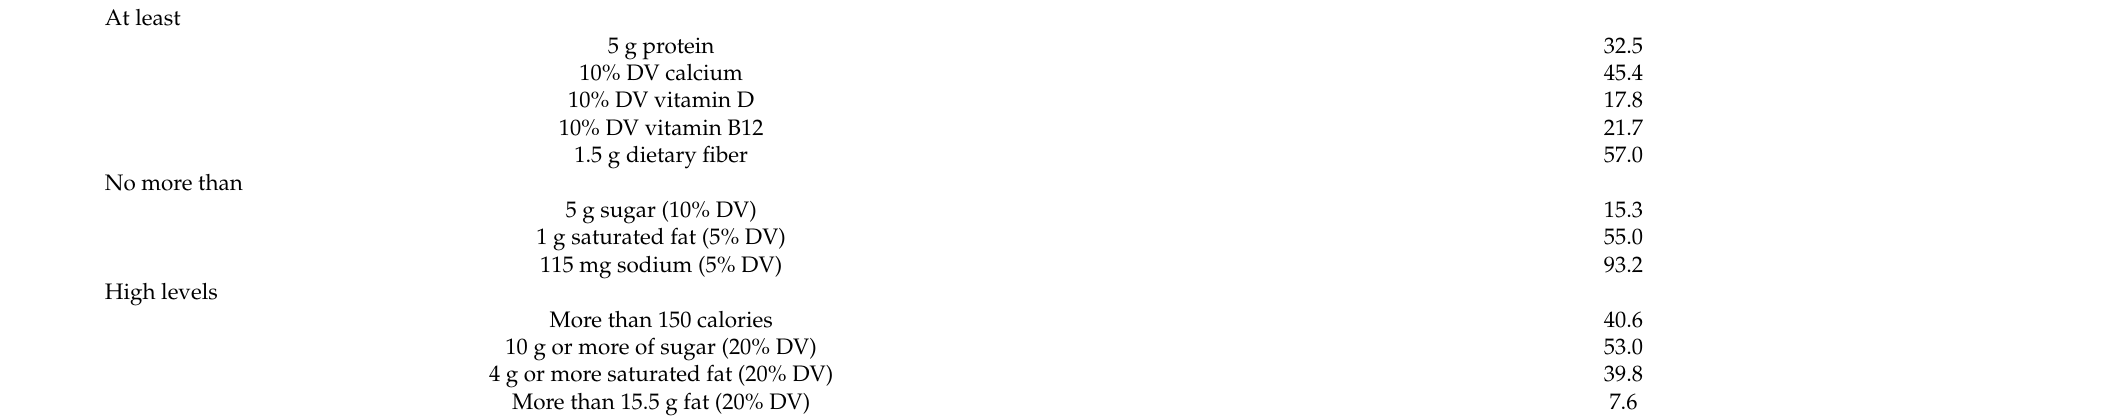
Table 2. Percentage of 249 non-dairy yogurt alternatives meeting or exceeding suggested guideline per